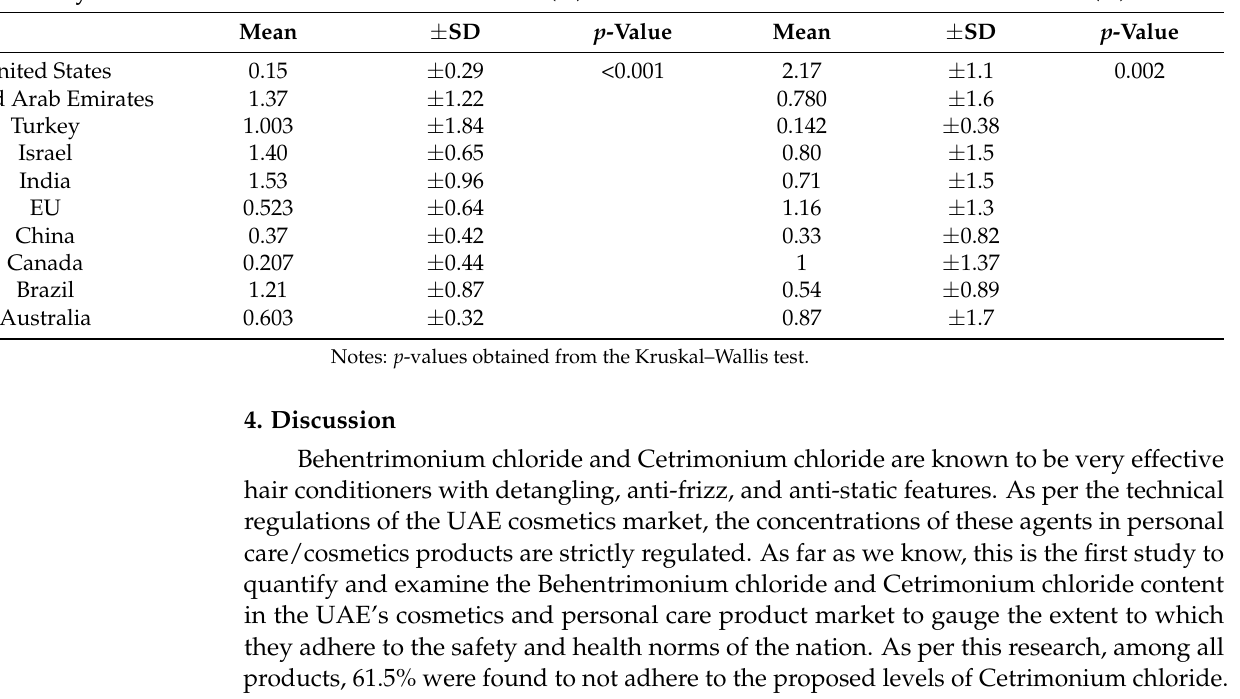
Table 6. Comparison of Cetrimonium chloride and Behentrimonium chloride content according to country of origin.